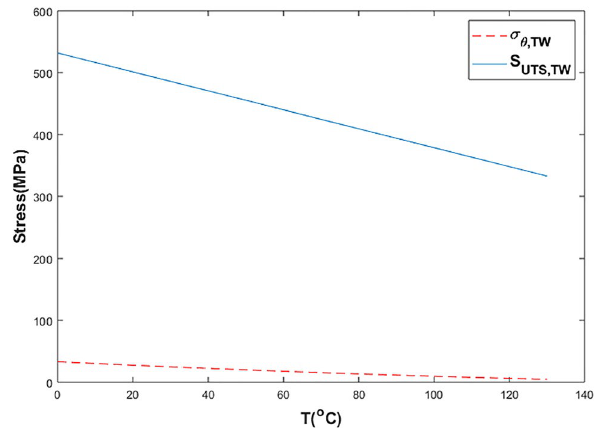
Fig. 11 Tensile stress and failure strength of sleeve vs